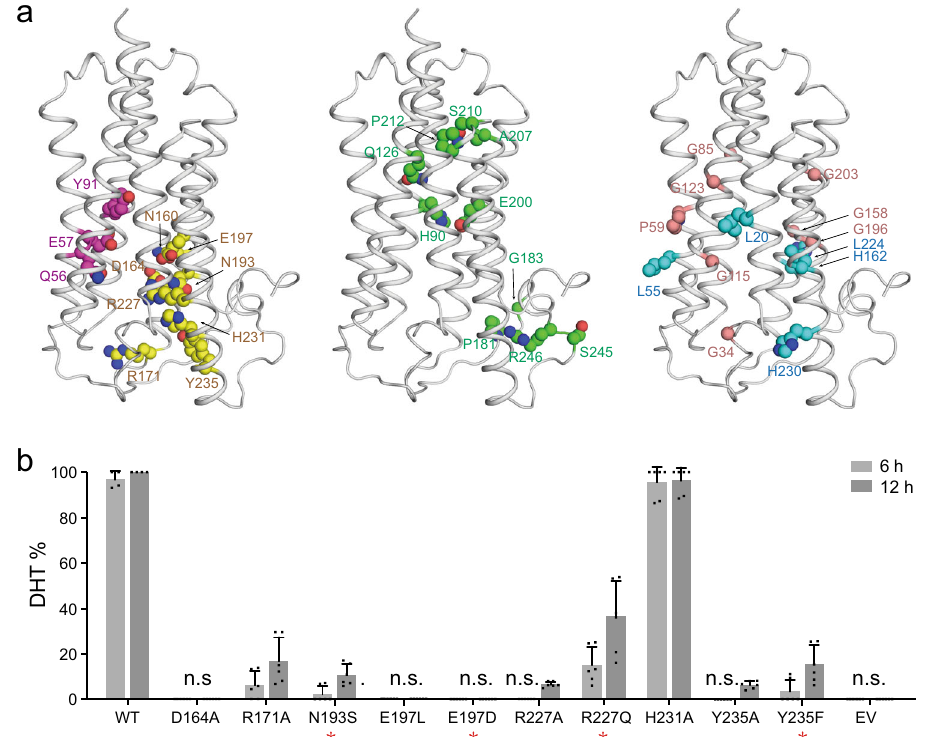
Fig. 4 Disease-related loss-of-function mutations in HsSRD5A2 model. a 32 disease-related loss-of-function mutations were classi fi ed into fi ve categories. Catalytic site residues are in magenta, NADPH-binding residues are in yellow, structural destabilizing mutations are in green, wheat, or cyan based on residue properties. b Biochemical analysis of disease-related HsSRD5A2 variants. All variants were transient expressed in HEK293T cells for 24 h. The cells were treated with [3H]-labeled T for 6 or 12 h. The collected and homogenized cell membranes were treated with [ 3 H]-labeled T. HsSRD5A2 activities were measured by the percentage of DHT detected by HPLC. Data are mean±s.d. derived from technically independent experiments in duplicate. Each experiment was reproduced three times on separate occasions with similar results. Red stars (*) below variant labels indicate the variants in